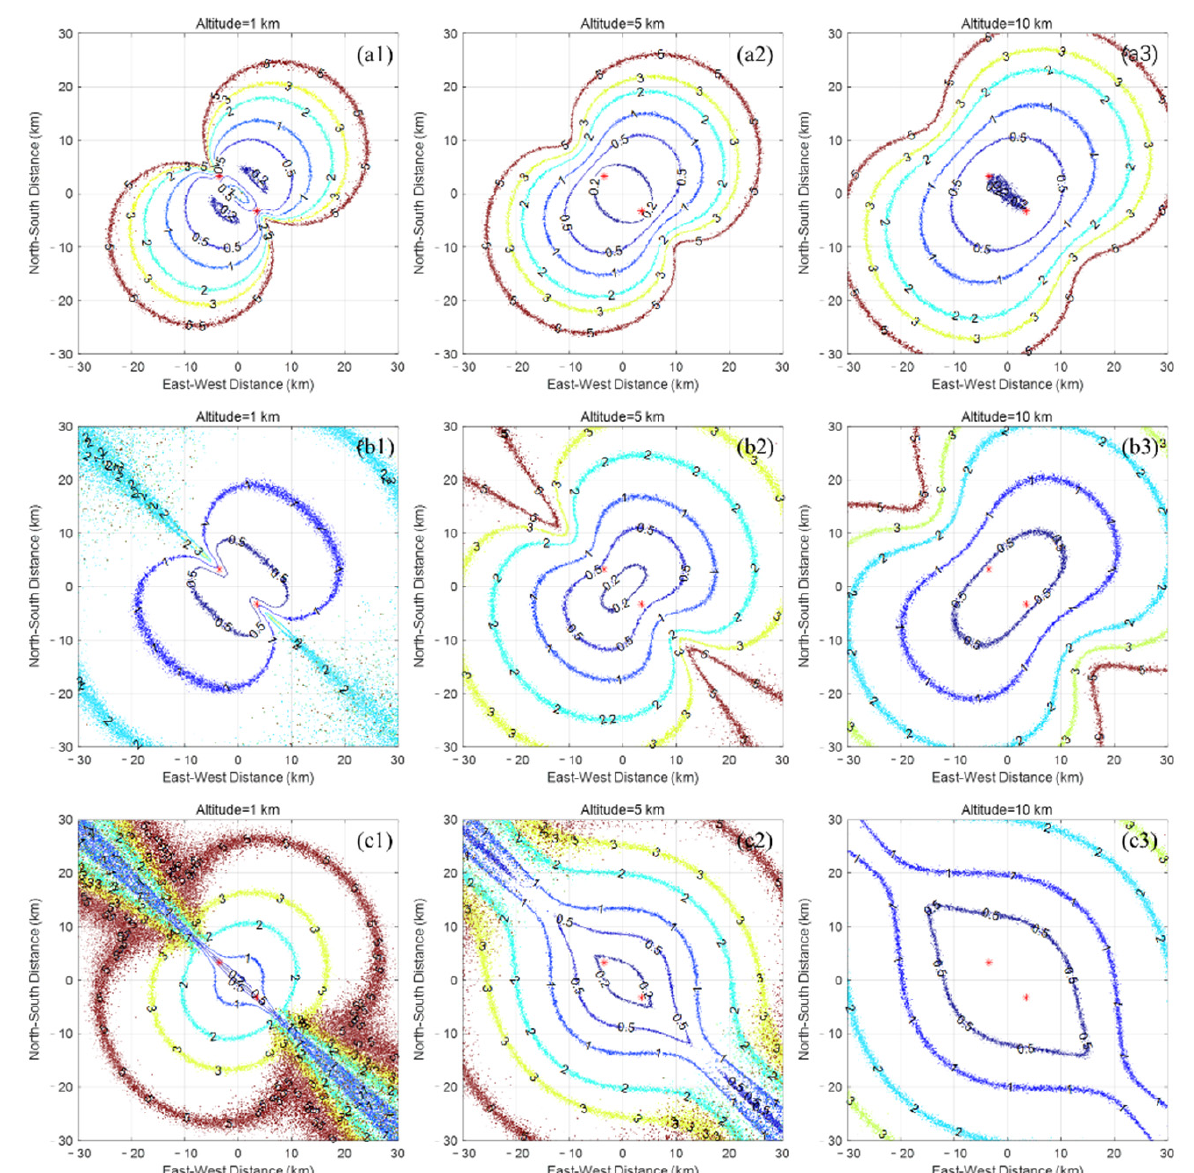
Figure 2. Mean location error using Monte Carlo simulation. ( a ) The estimated mean horizontal location error for sources at 1 km ( a1 ), 5 km ( a2 ), and 10 km ( a3 ). ( b ) The mean vertical location error for sources at 1 km ( b1 ), 5 km ( b2 ), and 10 km ( b3 ). ( c ) The mean length of the common vertical line for sources at 1 km ( c1 ), 5 km ( c2 ), and 10 km ( c3 ). The red asterisks represent the location of two